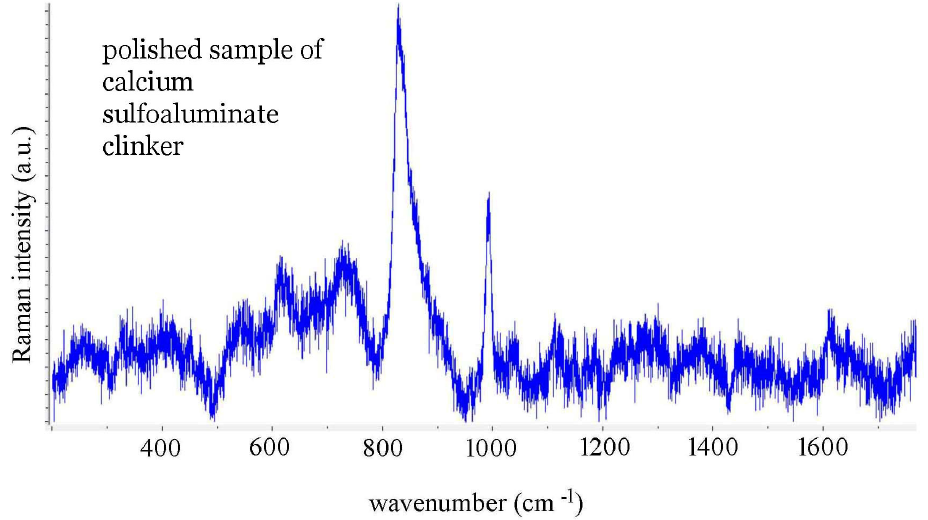
Figure 4. Raman spectrum of polished sample of calcium sulfoaluminate clinker.